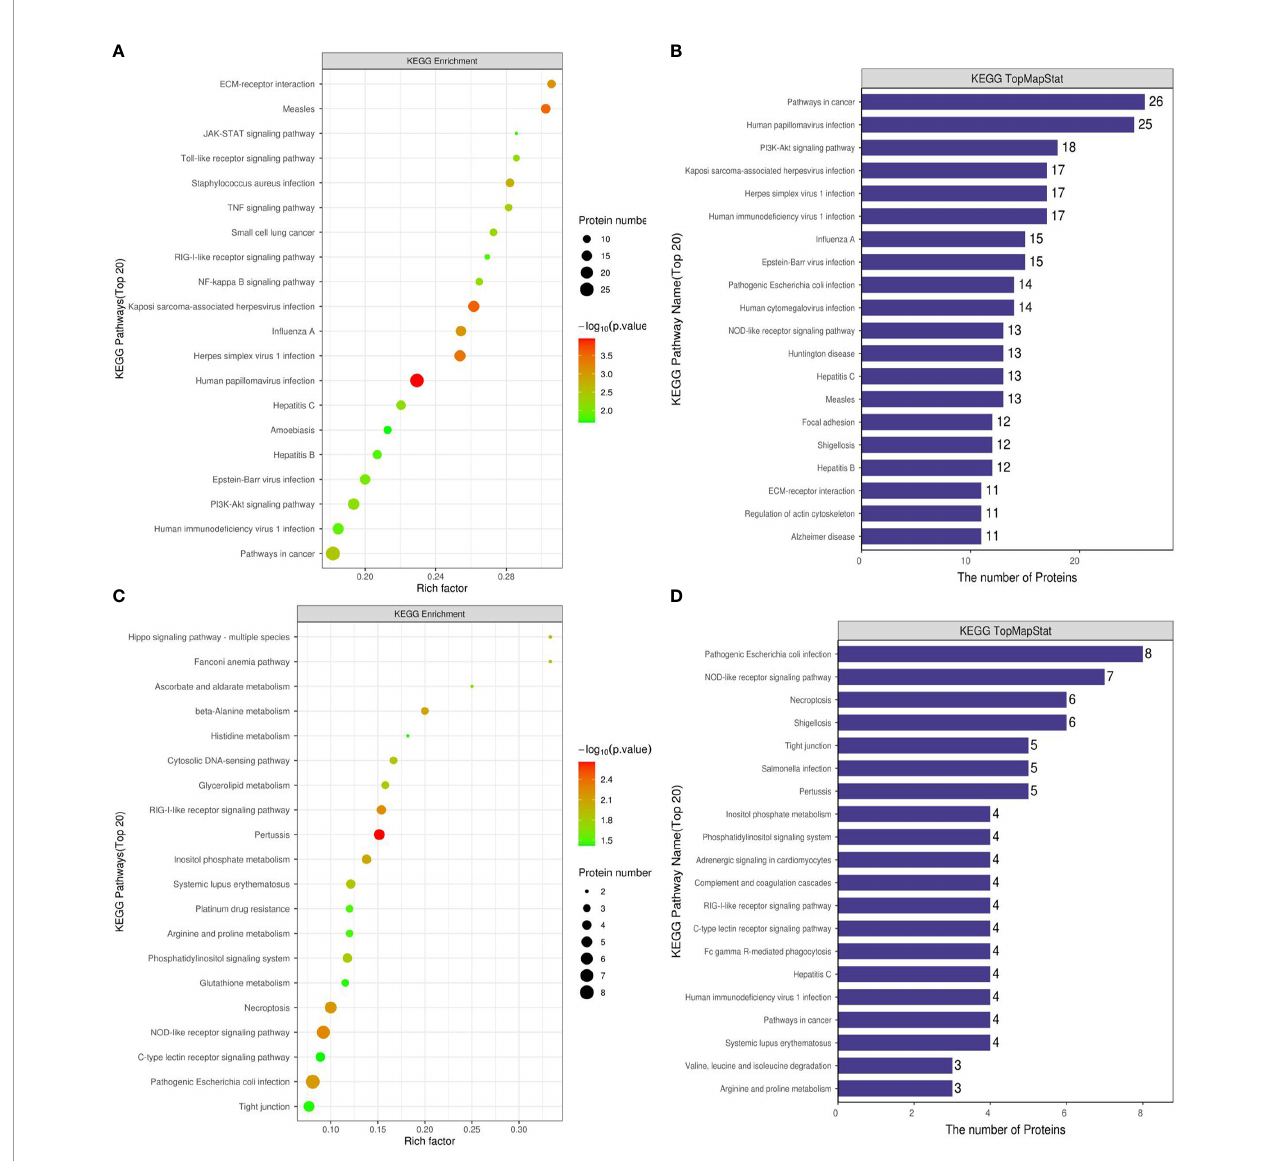
FIGURE 4 | KEGG functional enrichment analysis of Ca_vs_CaP and Cs_vs_Cr differentially expressed protein signaling pathways. (A, B) are Ca_vs_CaP differentially expressed proteins mainly concentrated in HPV infection, pathway in cancer, and PI3K-Akt signaling pathway. (C, D) are Cs_vs_Cr differentially expressed proteins mainly concentrated in pathogenic Escherichia coli infection, NOD-like receptor signaling pathway, and necroptosis RIPK1 and FADD proteins were mainly present in necroptosis and PRRs (containing NOD-like receptor signaling pathway, RIG-I-like receptor signaling system, and Toll-like receptor signaling